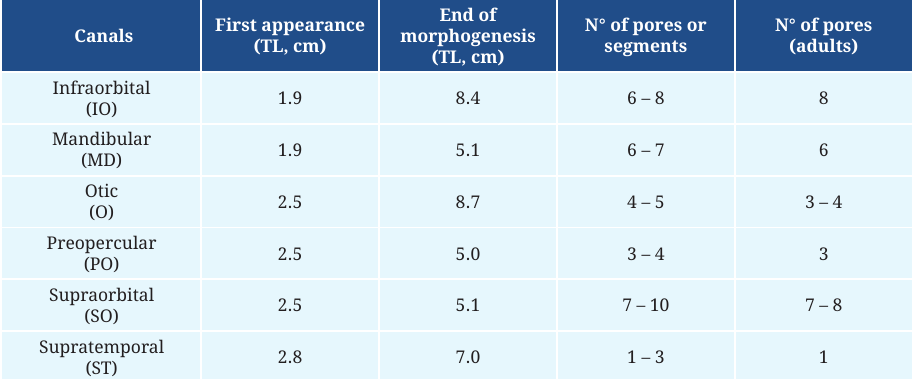
TABLE 1 | Number of pores of cephalic lateral-line canals during the ontogeny of Electrophorus varii . Mean number of segments or pores are presented for each canal in larval/juvenile and adult